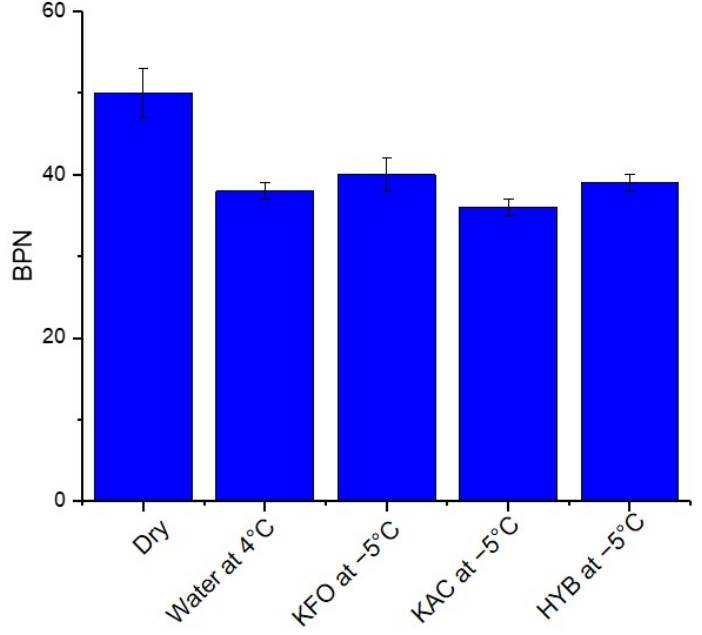
Figure 6. BPN obtained in wet condition as compared to the dry condition.